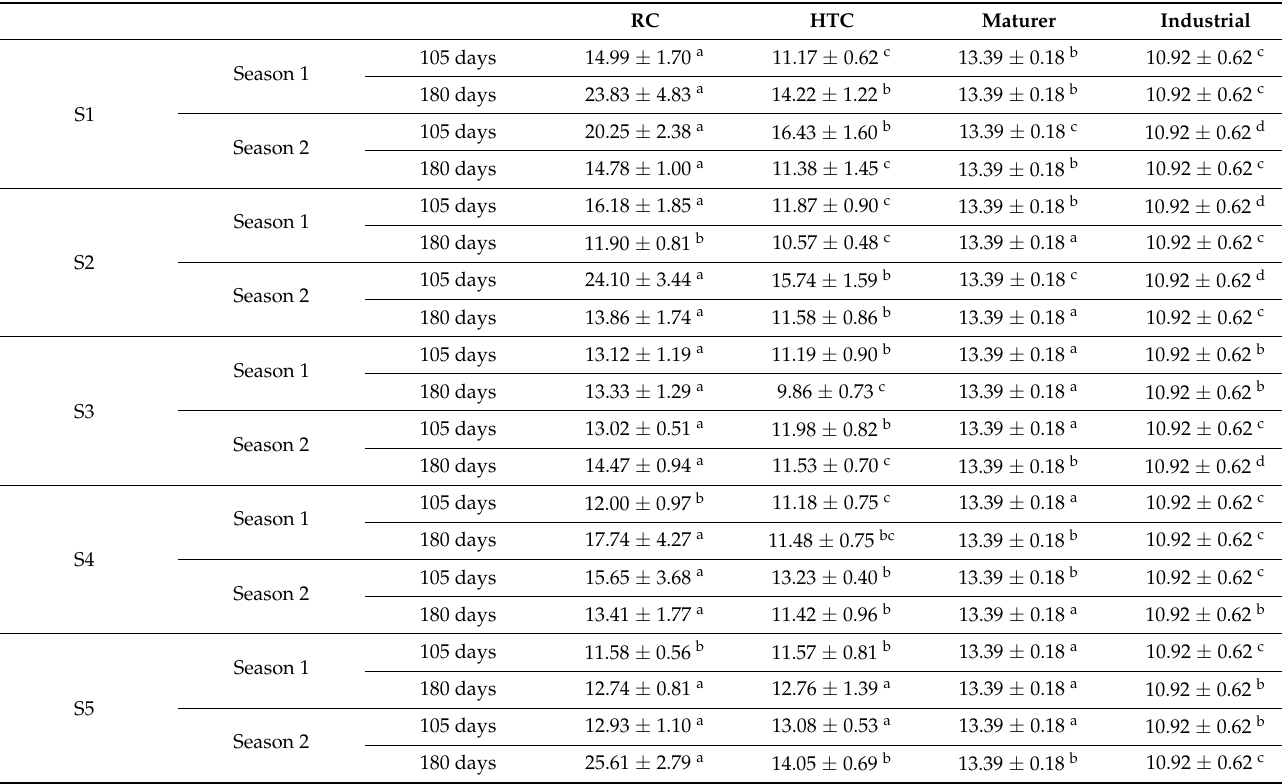
Table 3. Statistical comparison of Score